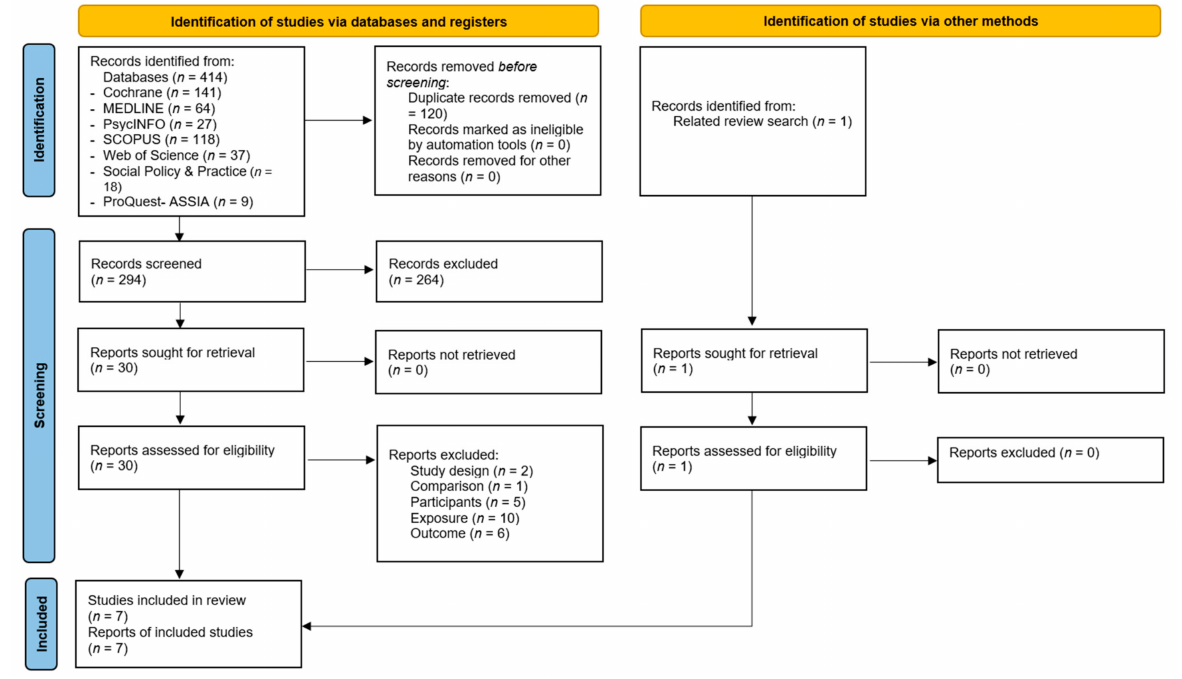
Figure 1. PRISMA screening